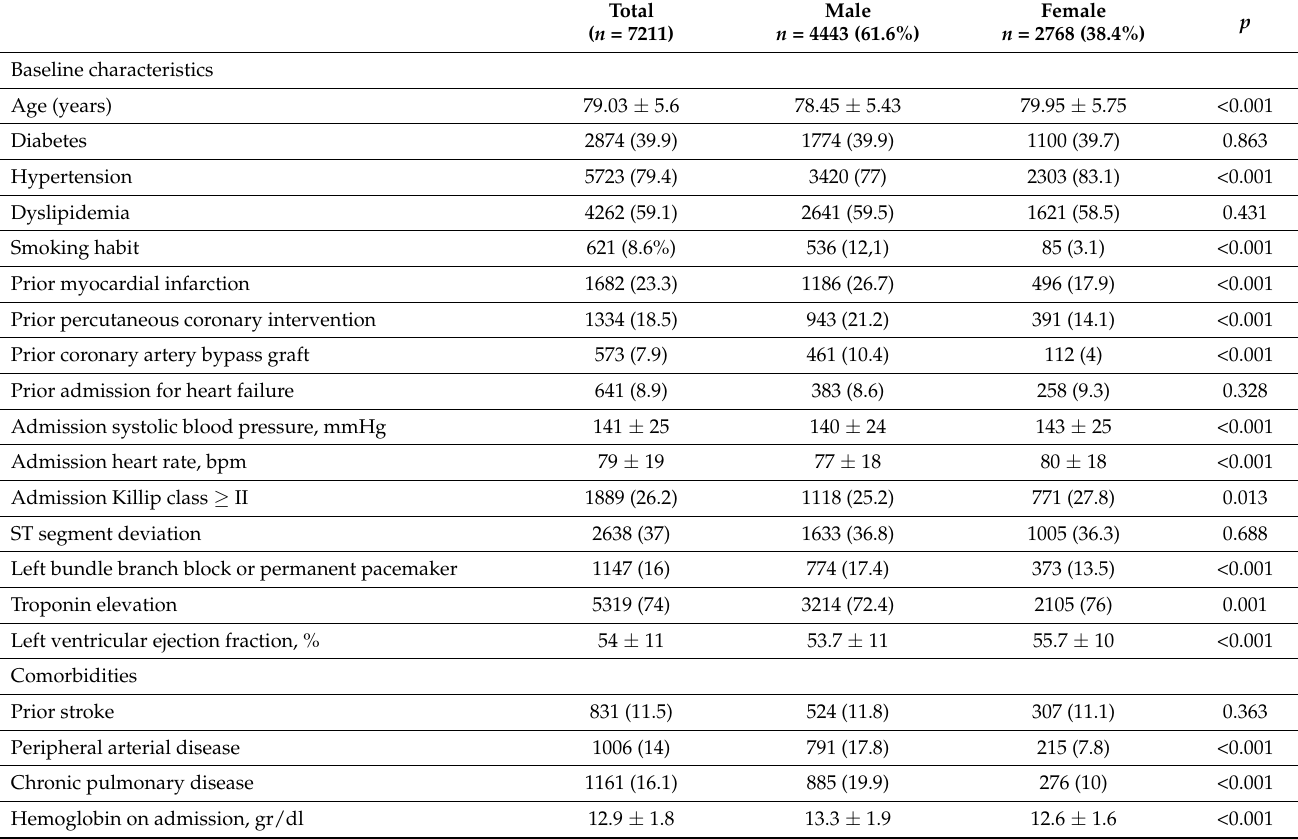
Table 1. Baseline demographic and clinical characteristics according to